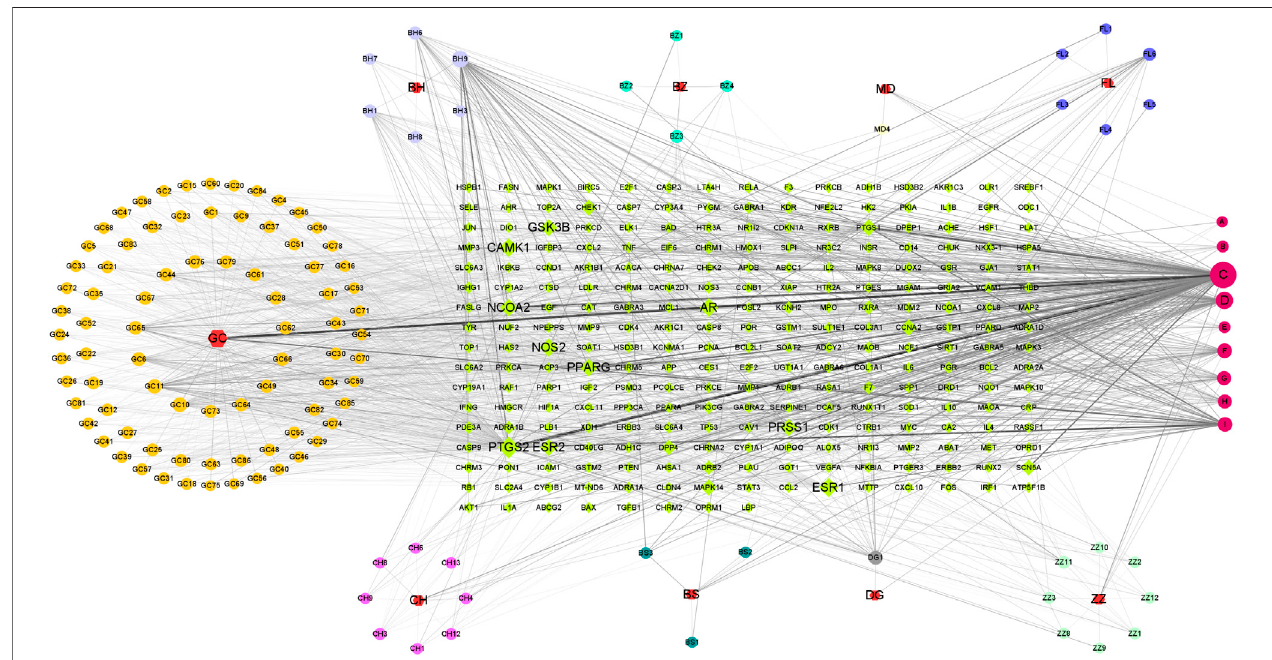
FIGURE 6 | Component-target network of